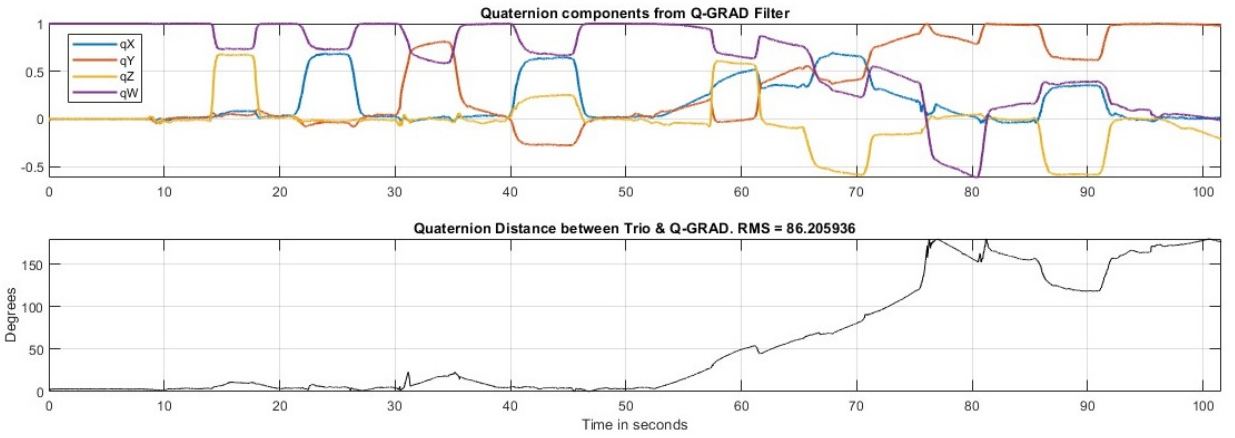
Figure A2. ( Top ) evolution of the quaternion components generated by the Q-GRAD onboard filter. ( Bottom ) evolution of the quaternion distance between the Trio quaternion result and the Q-GRAD quaternion result.